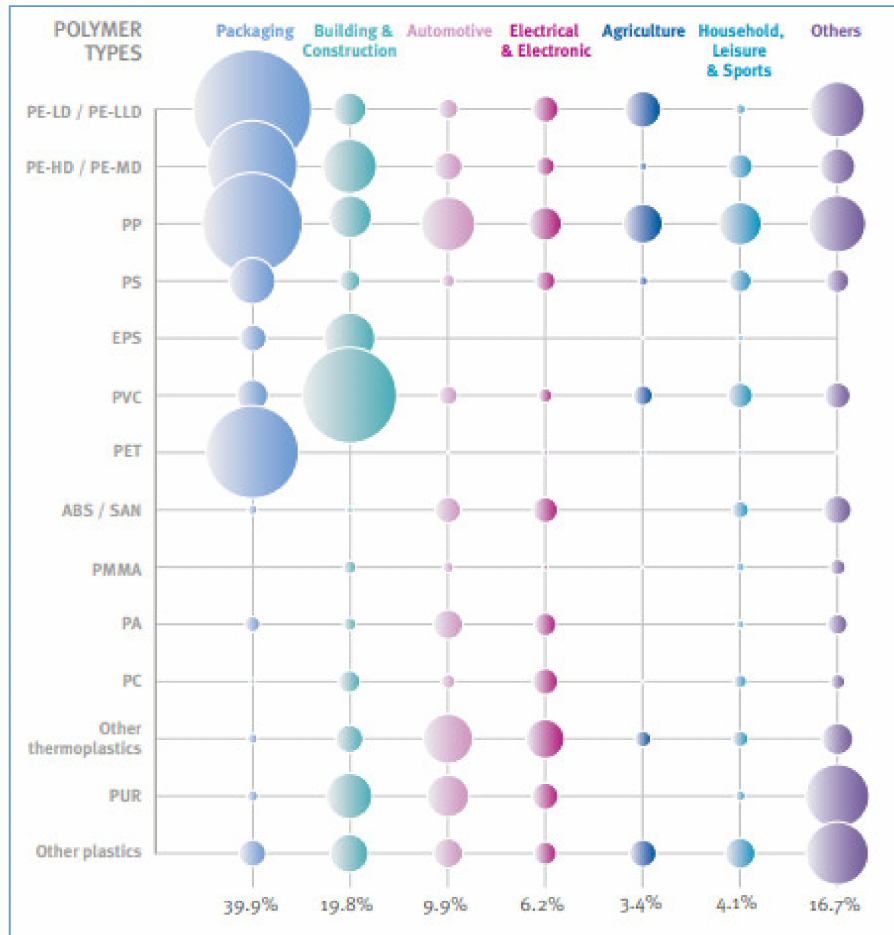
Figure 2. Plastics demand by segments and polymer types in 2018. Reprinted from [4], © 2020 with permission from